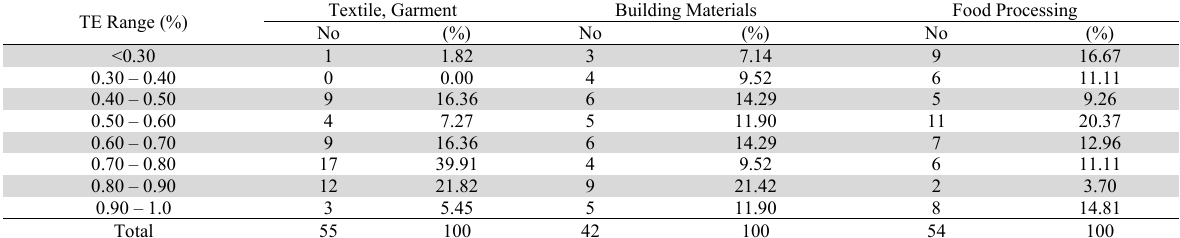
Frequency Distribution of Technical Efficiency Level TE Range